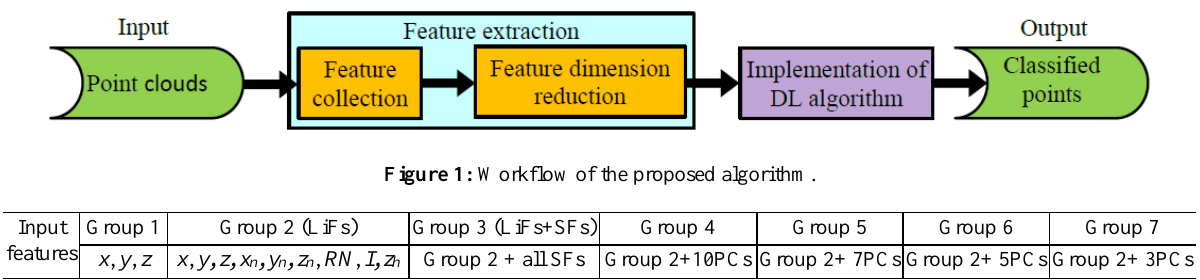
Table 1. Groups of features that are used in the network as the input vectors. Point coordinates ( x , y , z ), normalized point coordinates ( x n , y n , z n ), RN (return number), I (intensity), z h (height of the interest point), and N PCs ( N : number of PCs).